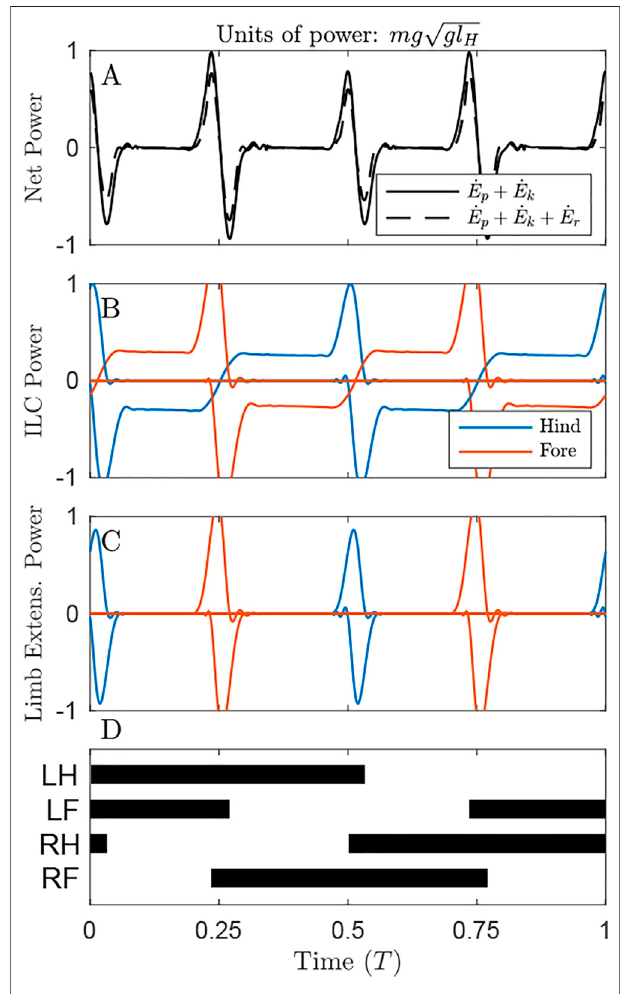
FIGURE 5 | Power through time for the solution optimizing Limb Extension Work, under the distributed mass model. (A) Oscillations in Net COM Power (NCP, black line) and Net System Power (NSP, dash line) occur primarily at transfer of support. Accounting for changes in rotational energy results in a slight reduction of peak NSP compared to NCP at transfer of support. (B) Throughout the cycle, the gait exhibits continuous Individual LimbsCOM Power, because the COM trajectory does not precisely follow the arcofeachlimbinstance. (C) LimbExtensionPowerexhibitspeaksattransfer of support. These peaks are almost twice the value observed in Figure 3C , but the total positive work is lower since there are substantial periods of zero- cost passive vaulting. (D) The gait diagram shows a typical singlefoot walk with alternating periods of triple and double limb stance, with phase offset of 0.25. Note that left and right limbs can be swapped with no change to gait energetics in this planar model.